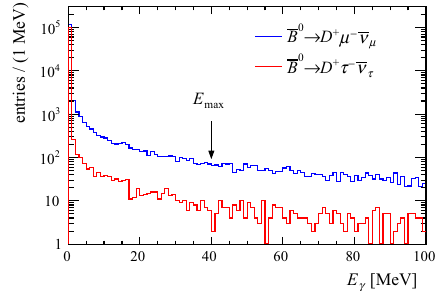
Fig. 1 Distribution of the total energy of the radiated photons, E γ , up to 100 MeV for B 0 → D + τ − ν τ and B 0 → D + μ − ν μ decays as simulated by Photos . Once a value of E max is chosen, e.g. 40 MeV as in the plot, all events with higher E γ values are